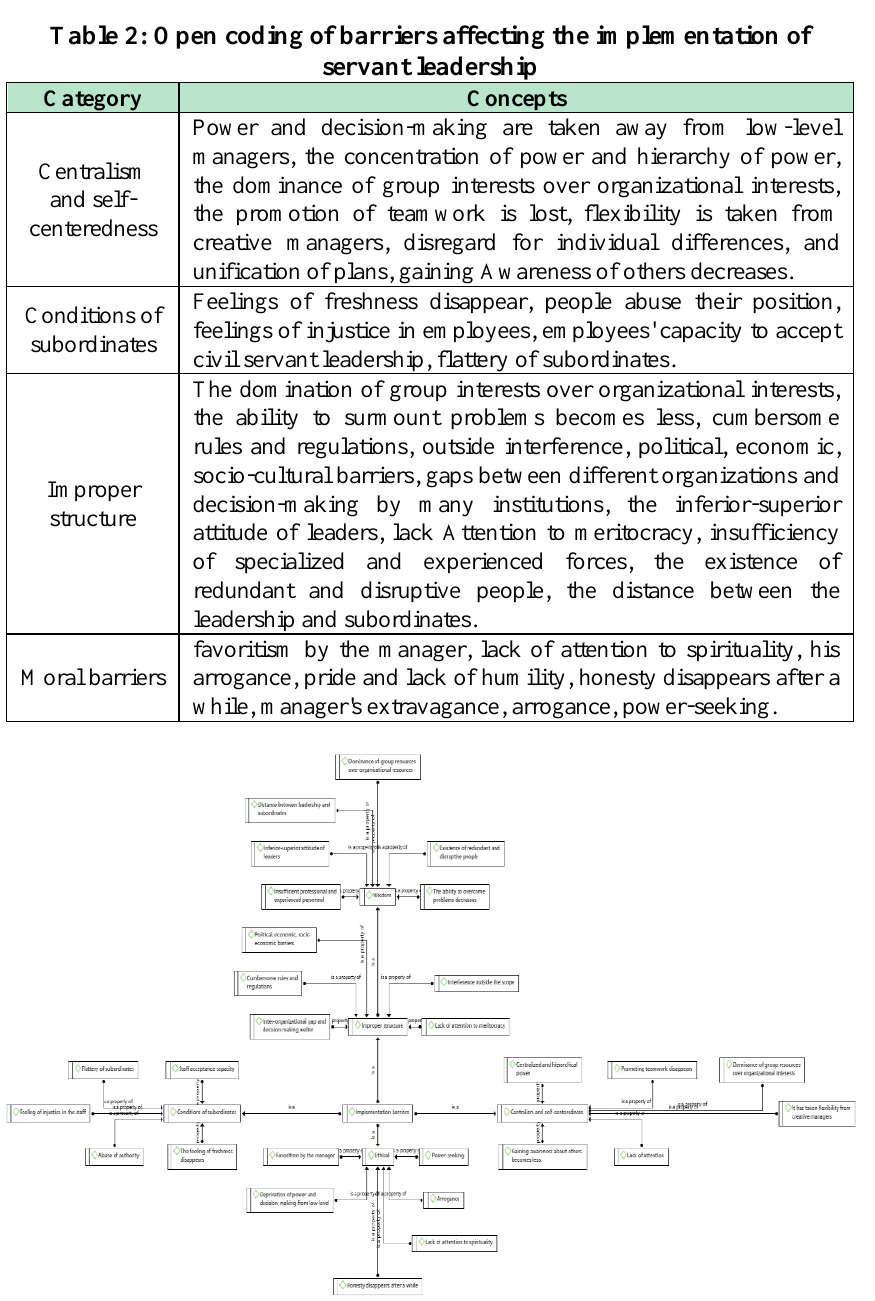
Figure 1: MAXQDA Output - Expert Team Focus on Obstacles Affecting Civil Servant Leadership